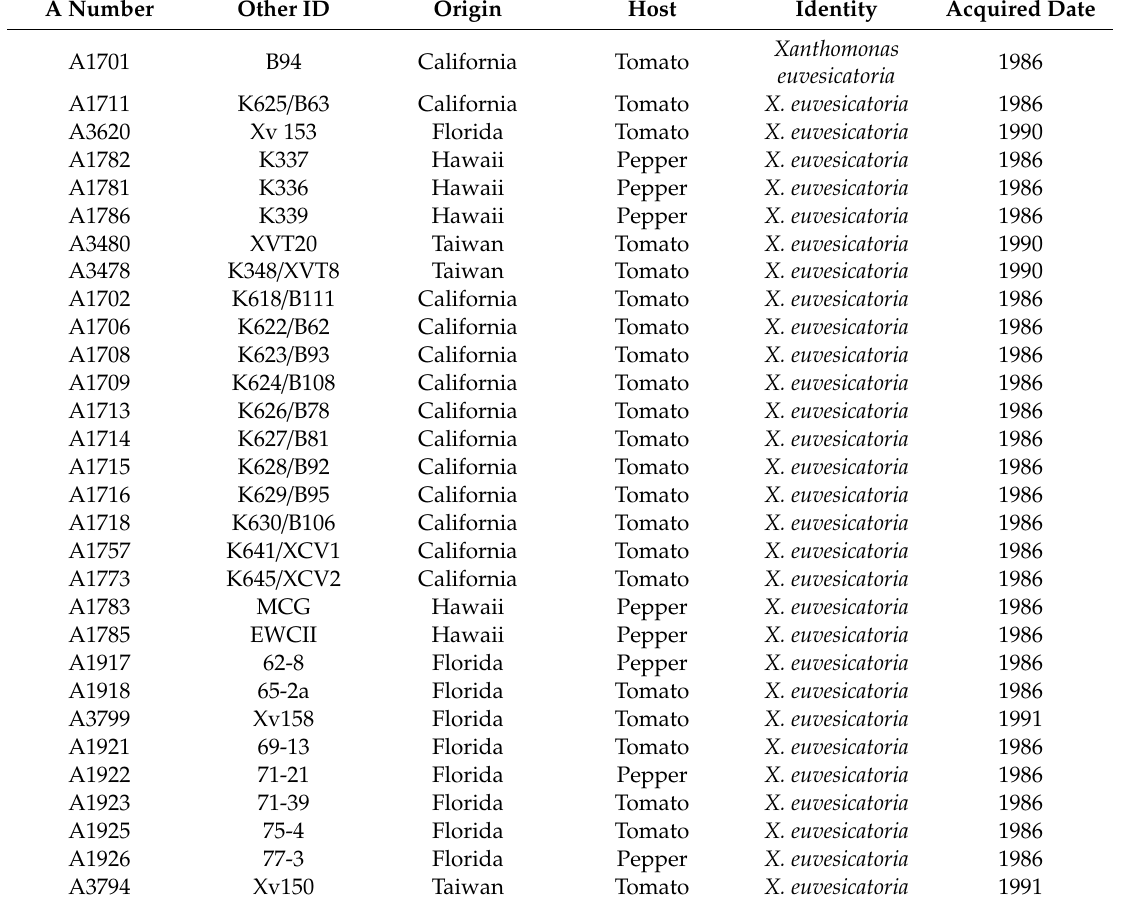
Table 1. Details of the Xanthomonas euvesicatoria , X. vesicatoria , X. gardneri , and X. perforans strains used in the population genetics